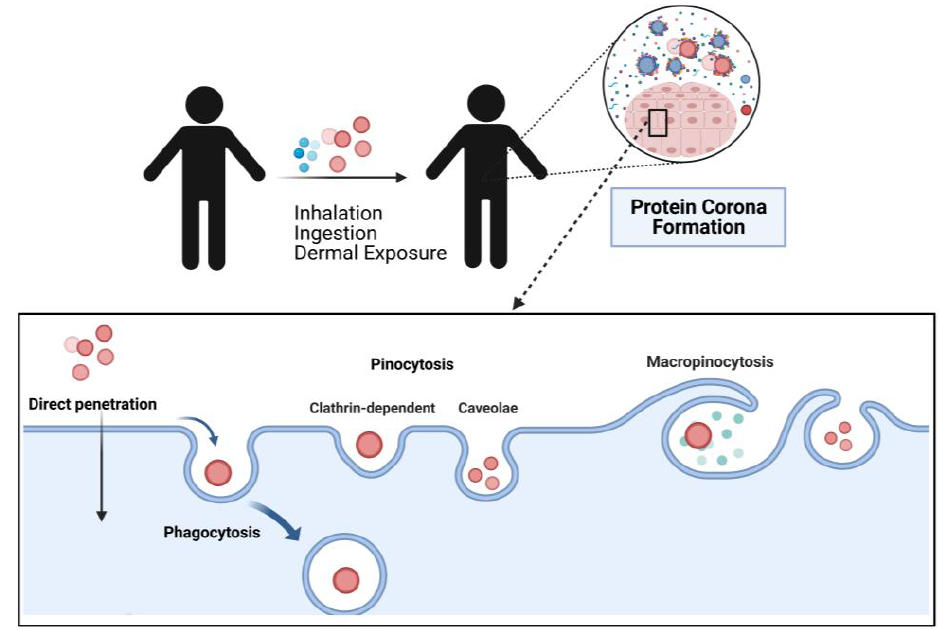
Figure 7. Schematic representation of the different manners through which NPs enter the human body and are internalized inside the cells.